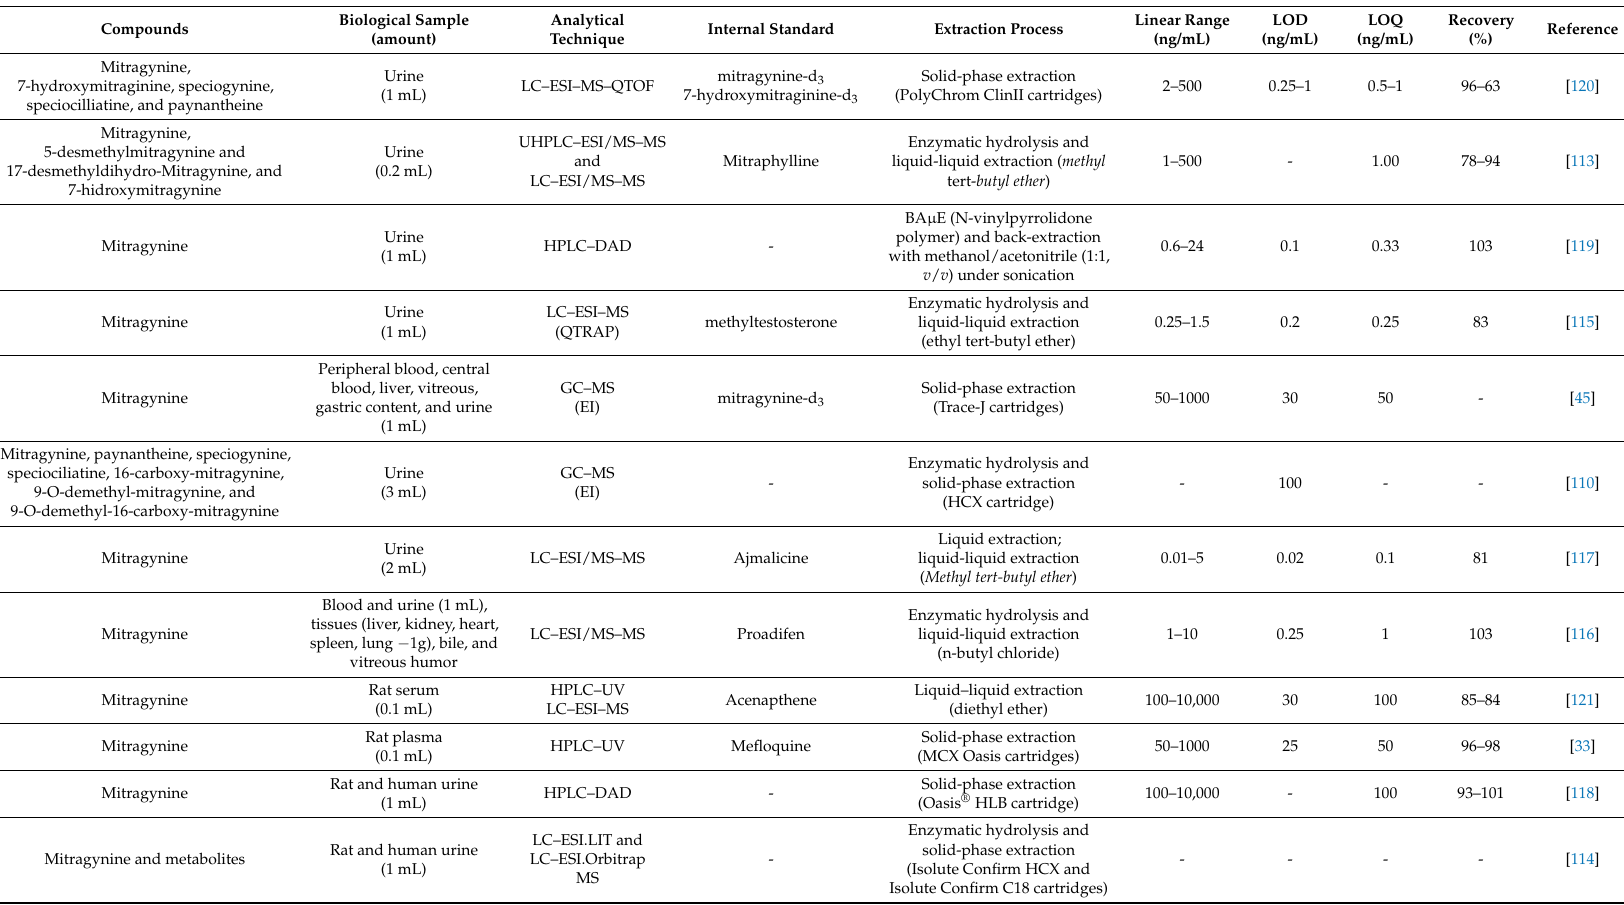
Table 1. Analytical methods for the identification and/or quantification of Mitragyna speciosa in biological